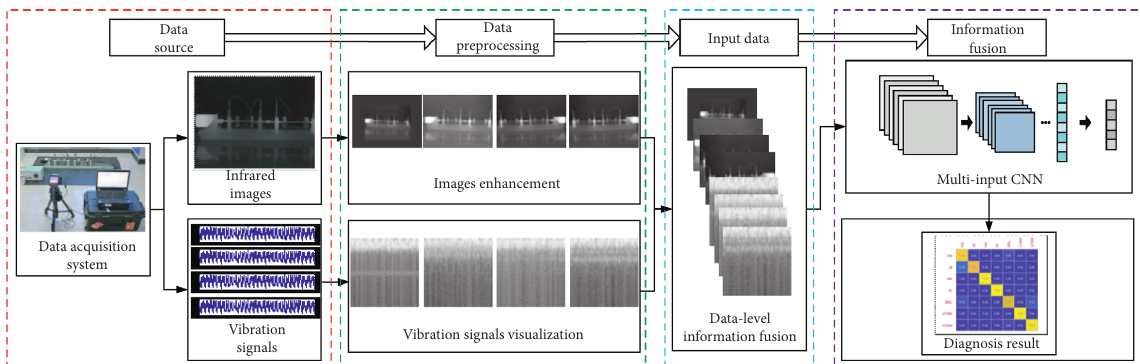
Figure 2: The diagram of the proposed method.